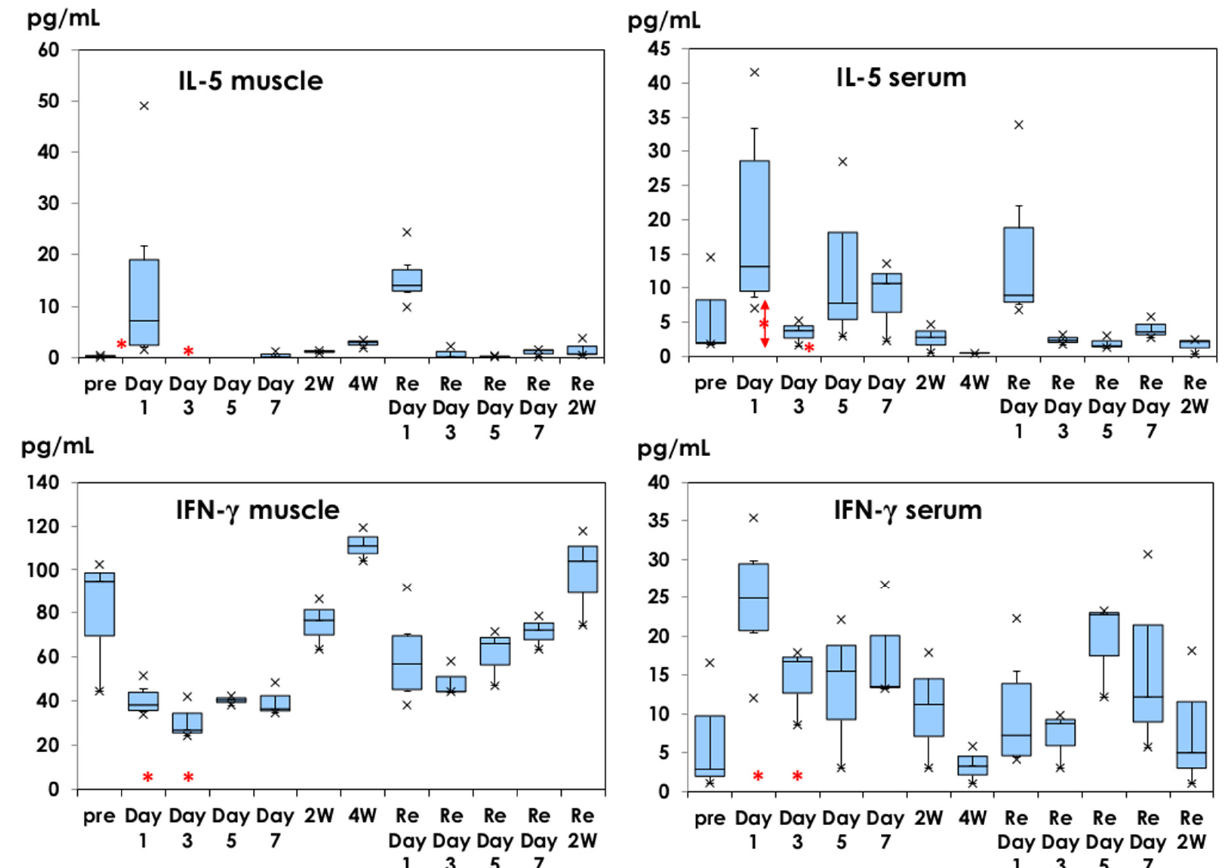
Figure 3. IL-5 and IFN- γ production in muscle tissues and serum samples. They are shown in box- and-whisker plots with a median titer and the range of 5–95%. Samples were obtained before injection, on days 1, 3, 5, and 7, and at 2 and 4 weeks after the first dose. The second dose was administered at 4 weeks and samples were obtained based on the same schedule. *: mean concentration of five mice as a control on day 1 of physiological saline injection : mean ± 1.0 SD. ×: outliers.